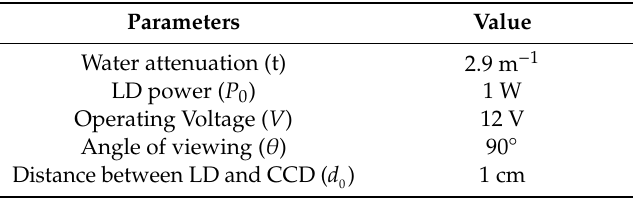
Table 5. Physical properties of experimental system.